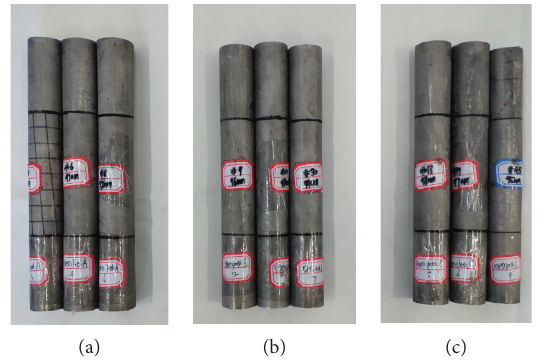
Figure 15: Pictures of specimens after loading stress paths (a) A, (b) B, and (c) C.